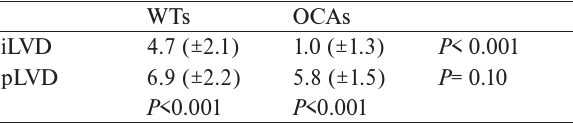
Table 1. Values of iLVD, pLVD in WTs and OCAs.